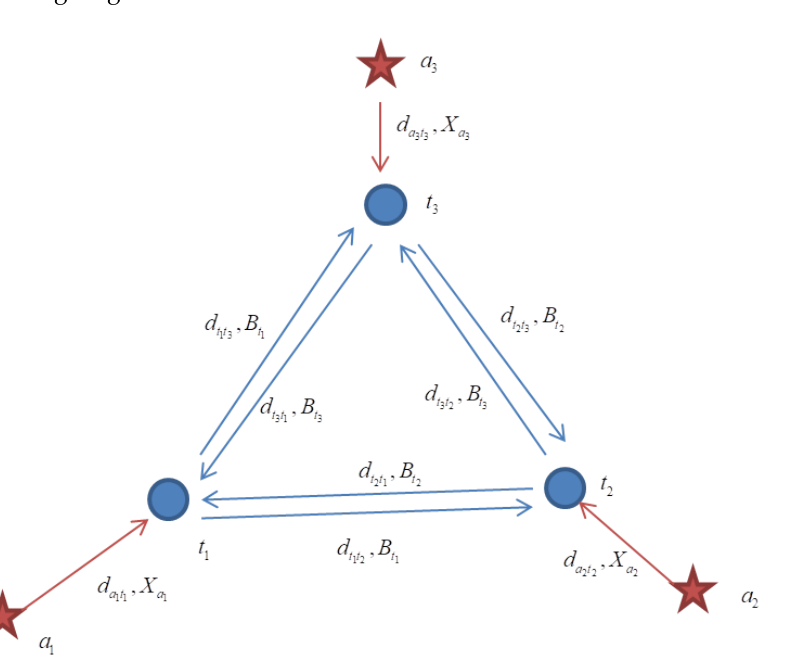
Figure 1. Localized anchor nodes are represented by the red five-pointed star, while unlocalized target nodes are represented by the blue circle. Each node sends its opinion of the distribution of the neighborhood node on the basis of its belief and measured